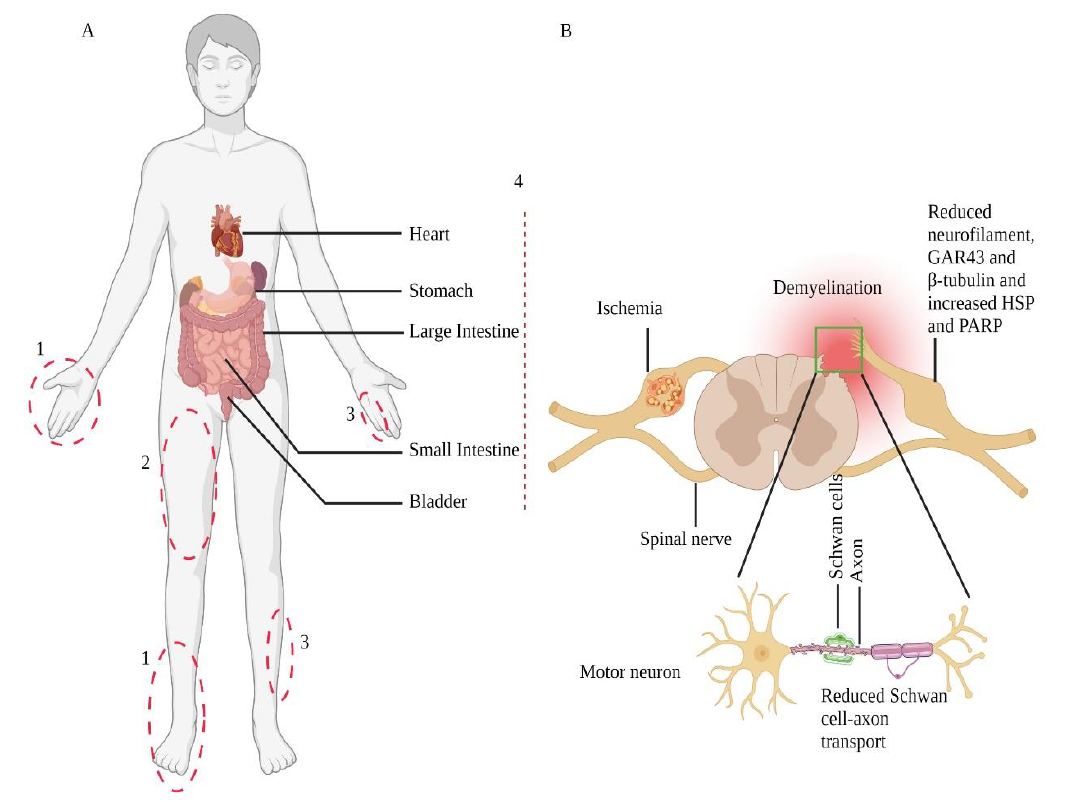
Figure 1. Nerve injury-prone areas and alteration of the peripheral nervous system in diabetic neuropathy. Diabetic neuropathy primarily affects distal sensory systems (1), eventually causing radiculopathy (2), mononeuropathy (3), and autonomic neuropathy or treatment-induced neuropathy (4) (part A ). Sensory neurons transmit their terminal information from the periphery to the dorsal horn of the spinal cord (part B ); contrarily, spinal cord-residing motor neurons relay information to the periphery. The Schwan cells myelinate axons and play a crucial role in preserving axonal functions. Therefore, in response to cellular injuries, such as diabetes, damaged Schwan cells or axons lead to neuronal cell body damage. These changes also include Schwan cell-axon transport, change in protein expression, demyelination, and degeneration. Adopted from REF [50].